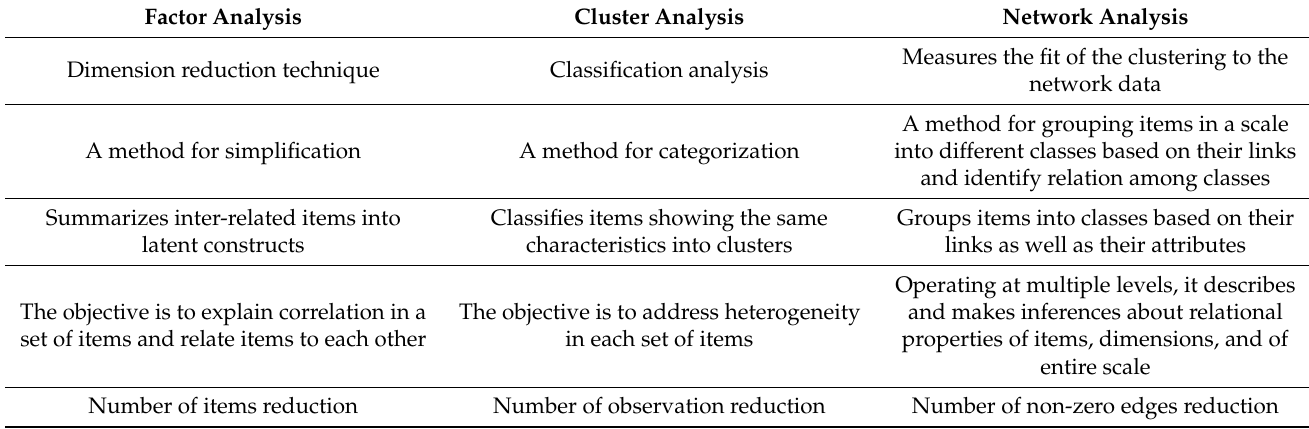
Table 1. Main characteristics of Factor-Cluster-Network